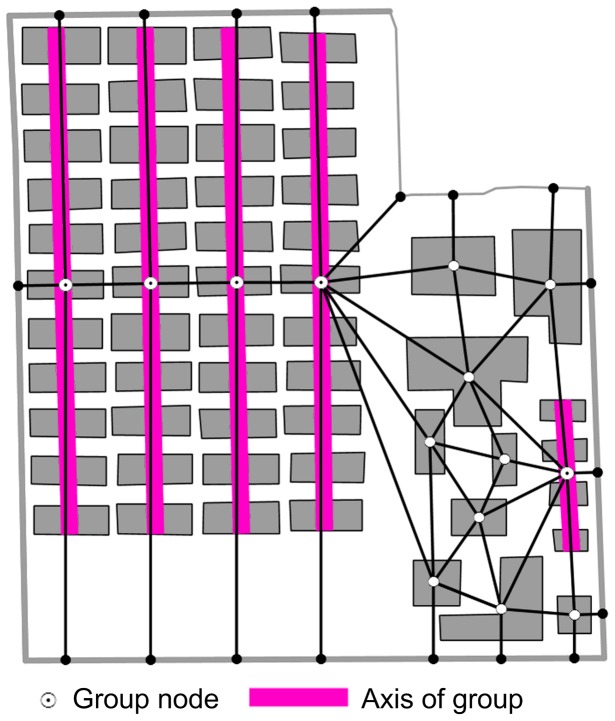
Adjusting proximity graph with building grouping information.Building groups are represented by group nodes in the adjusted proximity graph, and related proximity edges are deleted or collapsed.